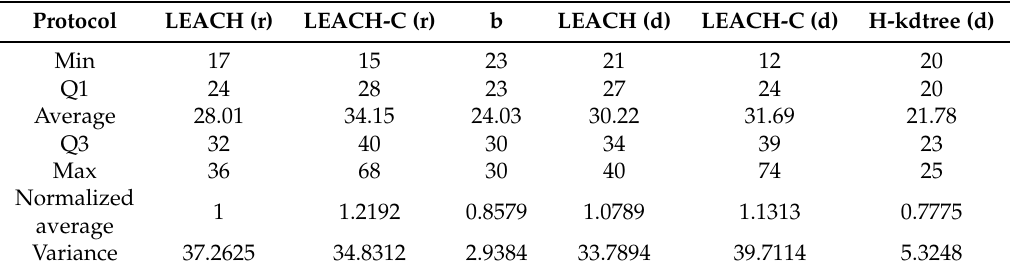
Table 3. Number of cluster head with 200 nodes. (r) random—(d) deterministic.